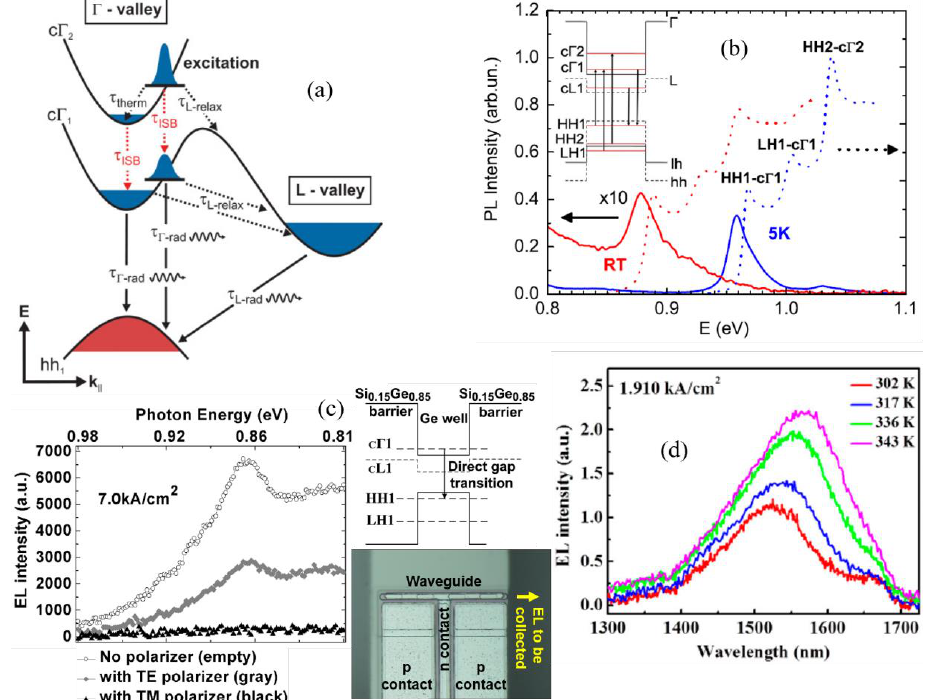
Figure 4. ( a ) Schematic view of scattering, thermalization, and recombination processes that occur in Ge/SiGe QWs of excited electrons [94]. ( b ) Photoluminescence spectra (full lines) and absorption spectra (dashed lines) of Ge/SiGe MQWs measured at room temperature and at 5 K [95]. ( c ) EL spectra from 80-µm-long waveguide light-emitting-diode, with and without an optical polarizer between the waveguide output and the detector, and SEM view of Ge/SiGe MQW light emitting diode in a waveguide structure. EL spectra were observed to be TE polarized [98]. ( d ) EL spectra at different temperatures under a constant injection current [109]. (Reproduced with permission from [94] © 2011 American Physical Society, [95,98] © 2011 AIP Publishing, and [109] © MDPI under Creative Commons Attribution (CC-BY) license).